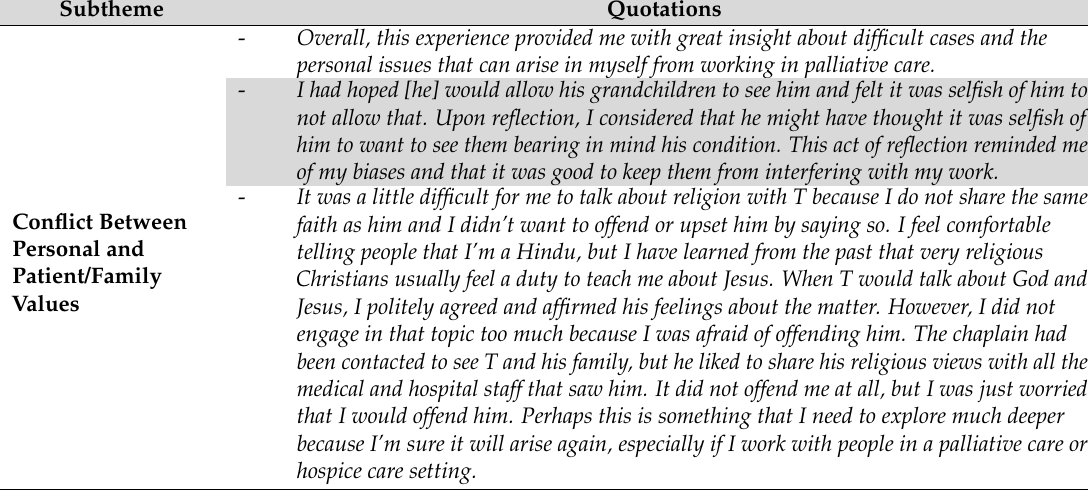
Table 11. Quotes related to the subtheme of conflict between personal and patient/family